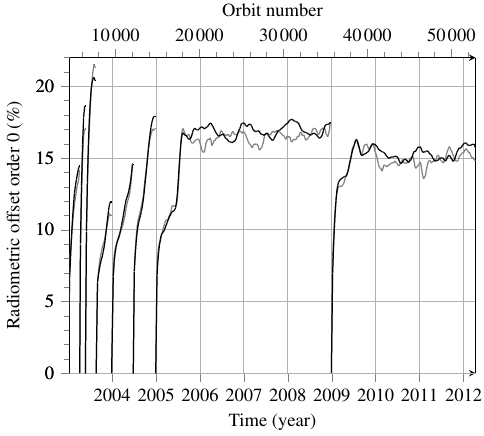
Figure 2. Zero-order radiometric offset retrieved from cloud-free SCIAMACHY spectra above the Sahara (black) and Australia (grey). The additive offset is given as a percentage of the total radi-